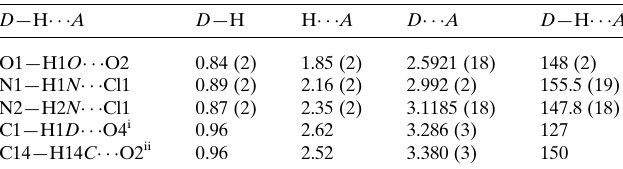
Table 1 Hydrogen-bond geometry (A˚ , (cid:4) ).